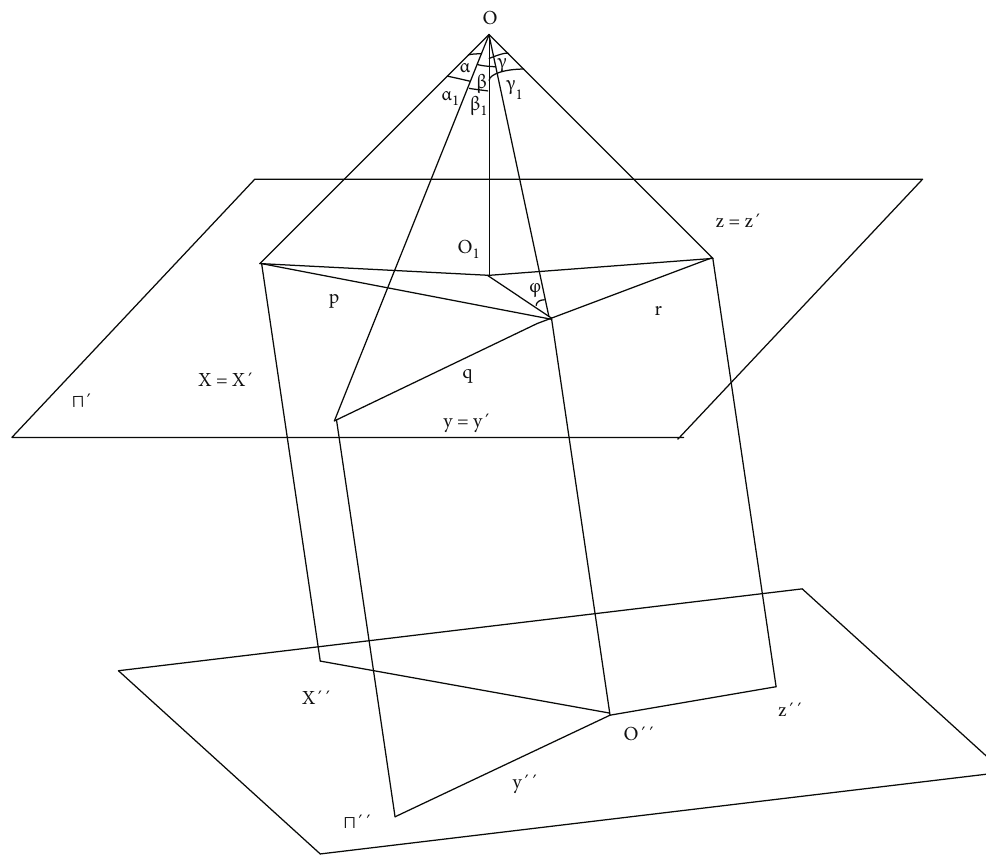
Figure 7: Geometric space relation of axonometric projection